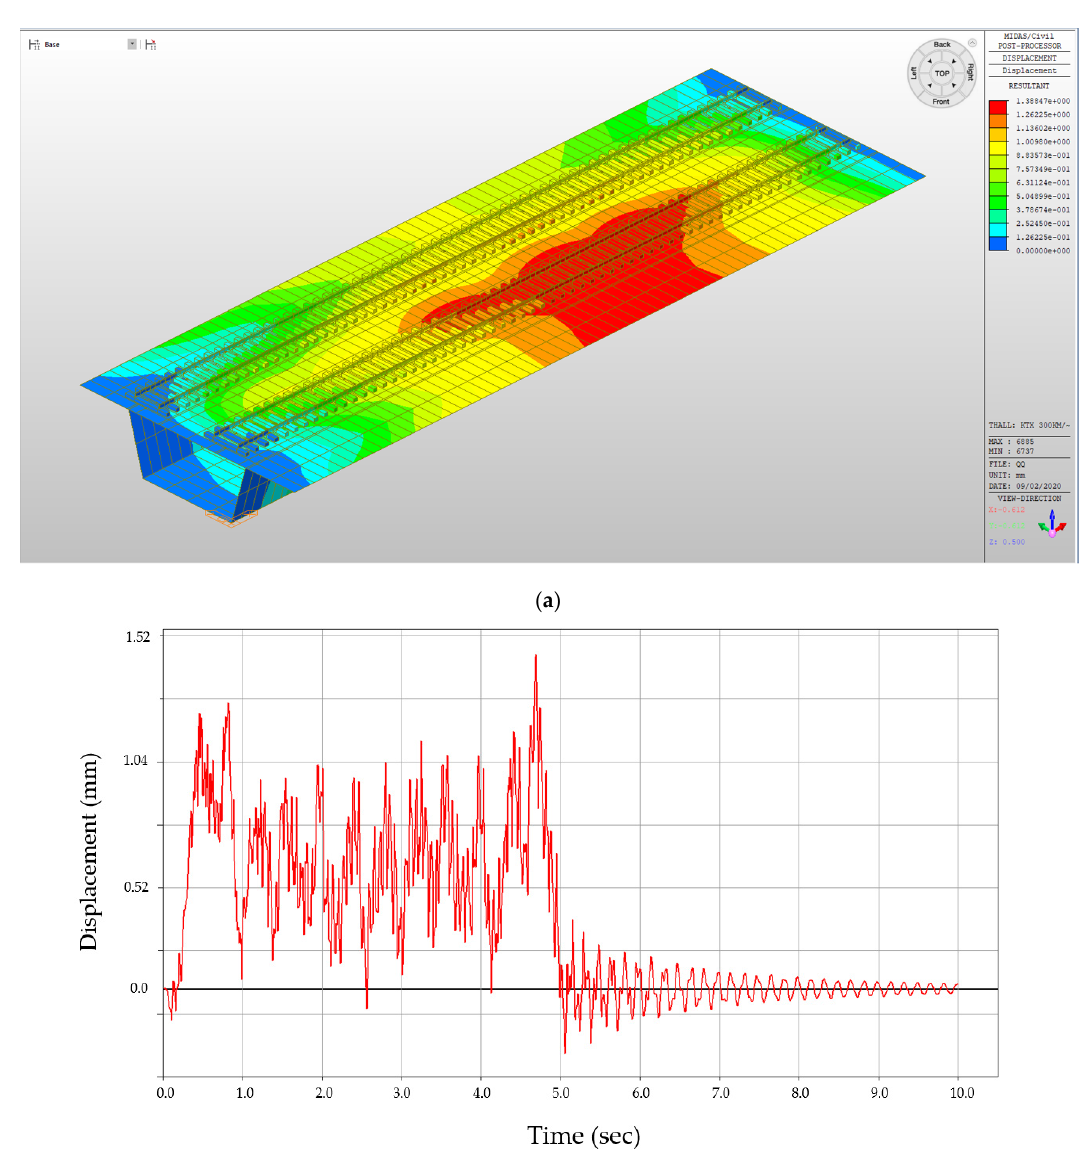
Figure 8. FEM analysis result (sample); ( a ) deformation analysis results of the track bridge structure model, ( b ) concrete bridge deck displacement analysis (1.38 mm).